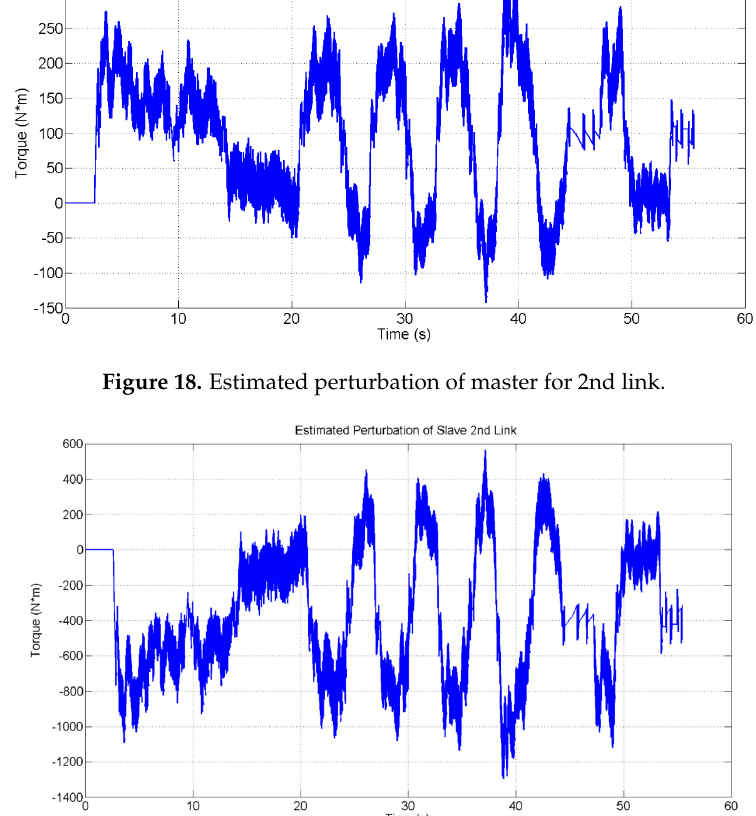
Figure 19. Estimated perturbation of slave for 2nd link.